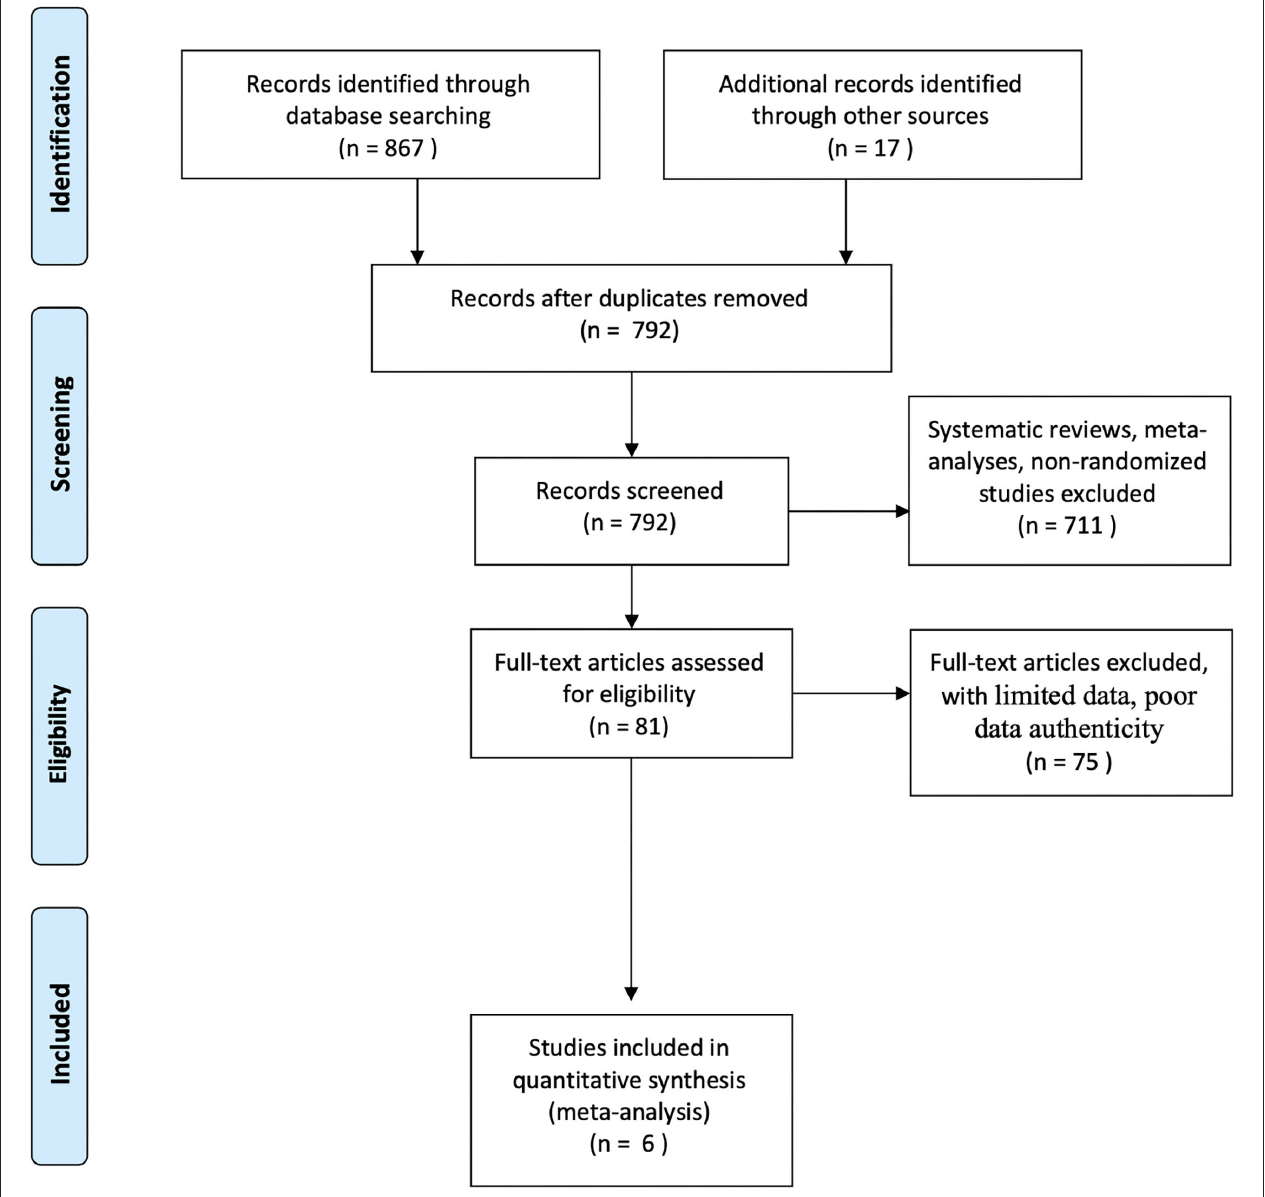
FIGURE 1 | Schematic illustration of the study selection